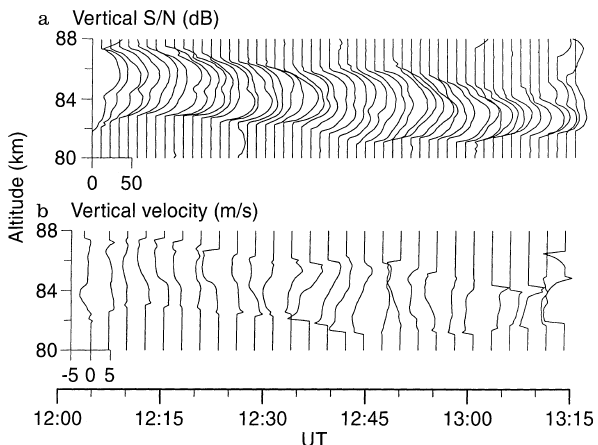
Fig. 7a, b. Altitude profiles of a the vertical S/N and b the vertical velocity, on 19